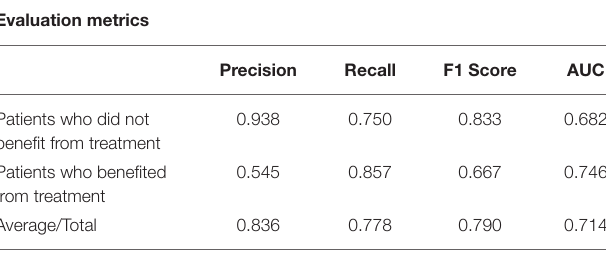
TABLE 5 | Evaluation Metrics of RF classification.